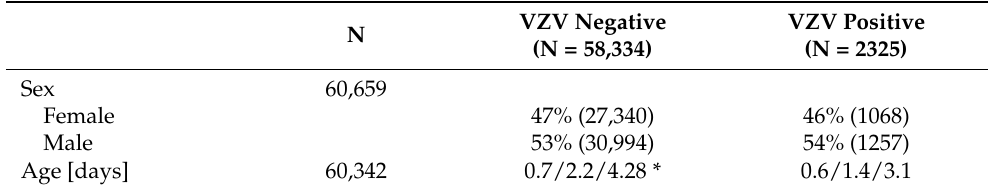
Table 1. Characteristics of units analyzed. Descriptive statistics are reported and stratified for outcome class, i.e., negative or positive case of VZV in the corresponding year.